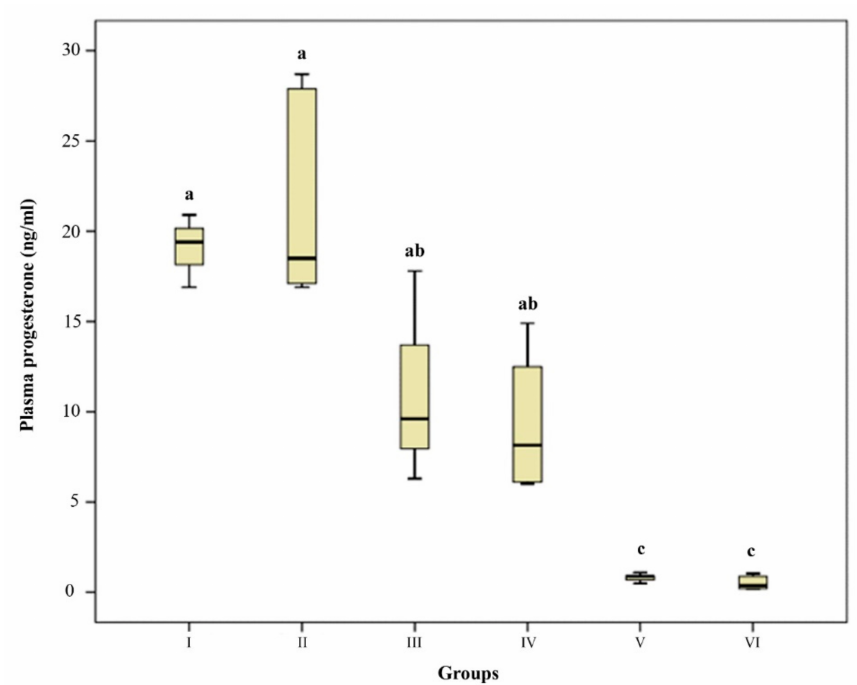
Figure 2. Plasma Progesterone concentration. Box-and-whisker plot. Group I ( n = 3, 24–29 days), Group II ( n = 8, 32–40 days), Group III ( n = 4, 41–46 days), Group IV ( n = 6, 53–61 days) Group V ( n = 6, interestrus), Group VI ( n = 6, estrus). a,b,c p <